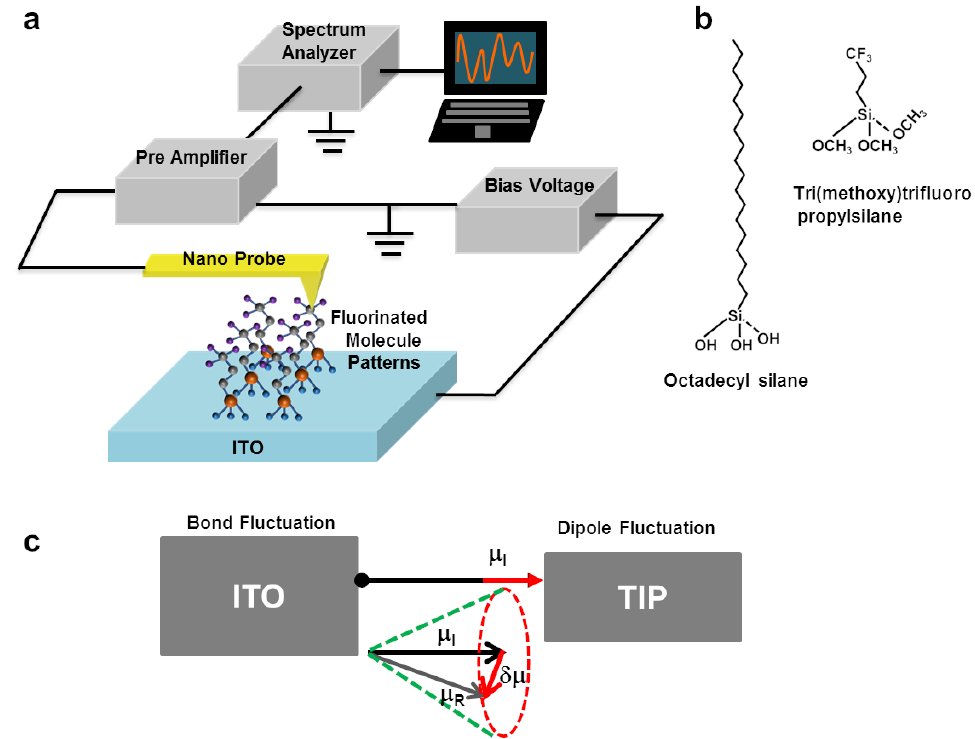
Figure 1. Schematic diagrams showing the scanning noise measurement setup and chemical struc- tures of molecular wires. ( a ) Schematic diagram depicting noise and current measurement setup for a molecular wire pattern. A dc bias was applied to the ITO substrate, and currents and noise signals through the probe were measured by a homemade network analyzer. ( b ) Chemical structures of octadecyl(trihydroxy)silane and tri(methoxy)trifluoropropylsilane molecular wires, which were used to pattern hydrogenated-SAM and fluorinated-SAM, respectively. ( c ) Schematic diagram showing the possible formation of a dipole at the tip. δ µ is the change in a dipole moment due to a change in a molecular confirmation or change in position of contact atoms.